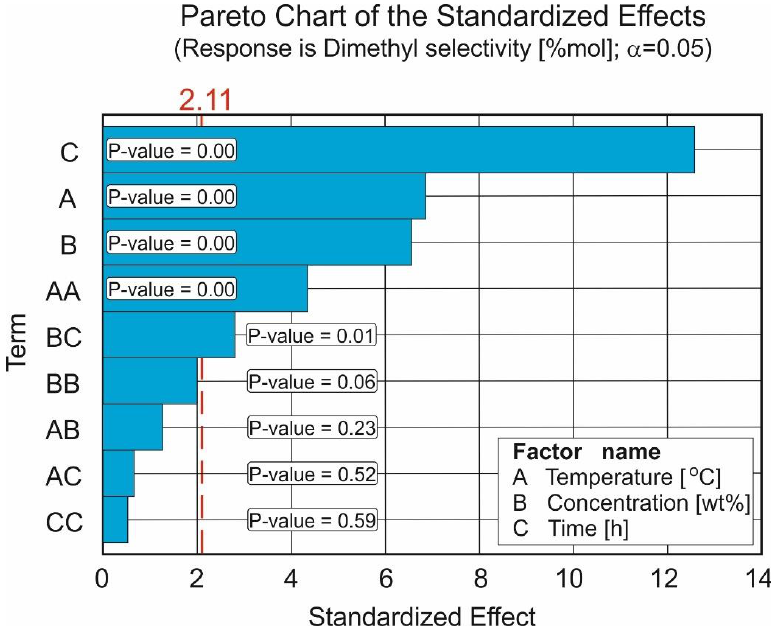
Figure 3. Levels of important and not important factors of the dimethyl selectivity for α = 0.05. Regression equation in uncoded units: